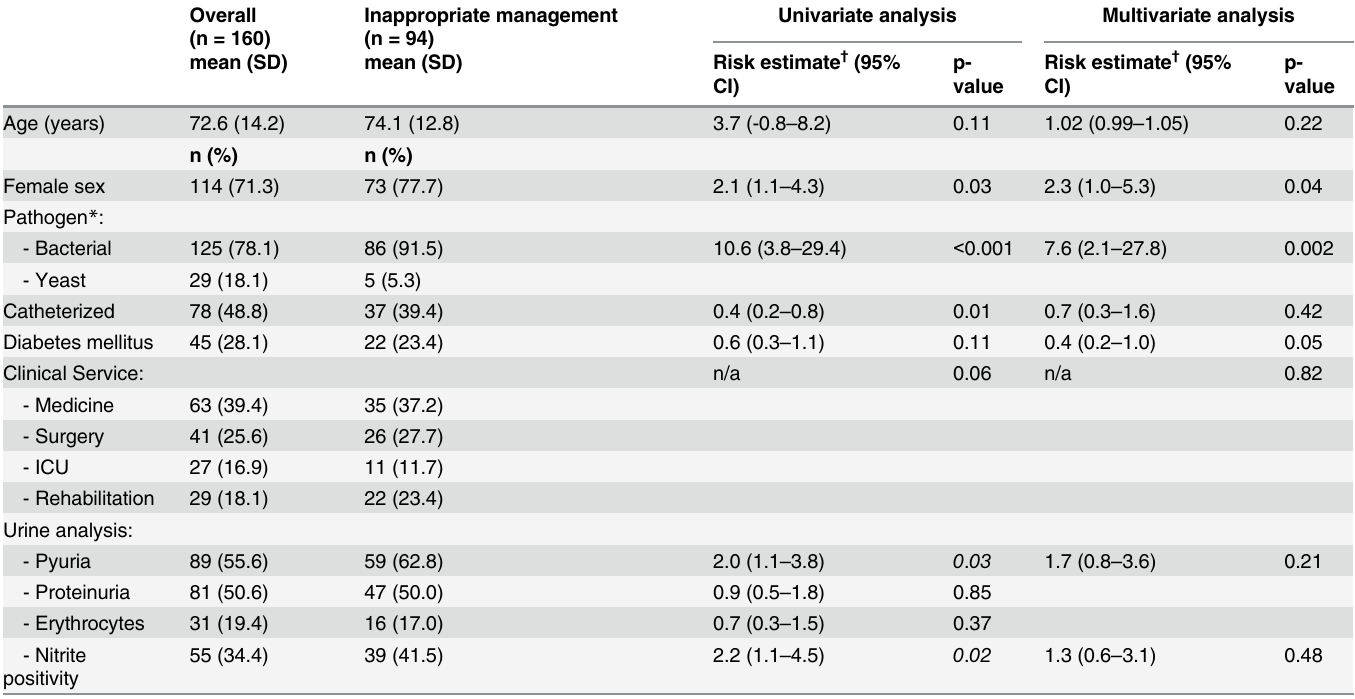
Table 1. Patient characteristics and risk factors for inappropriate ABU management at baseline (January 30 to April 17